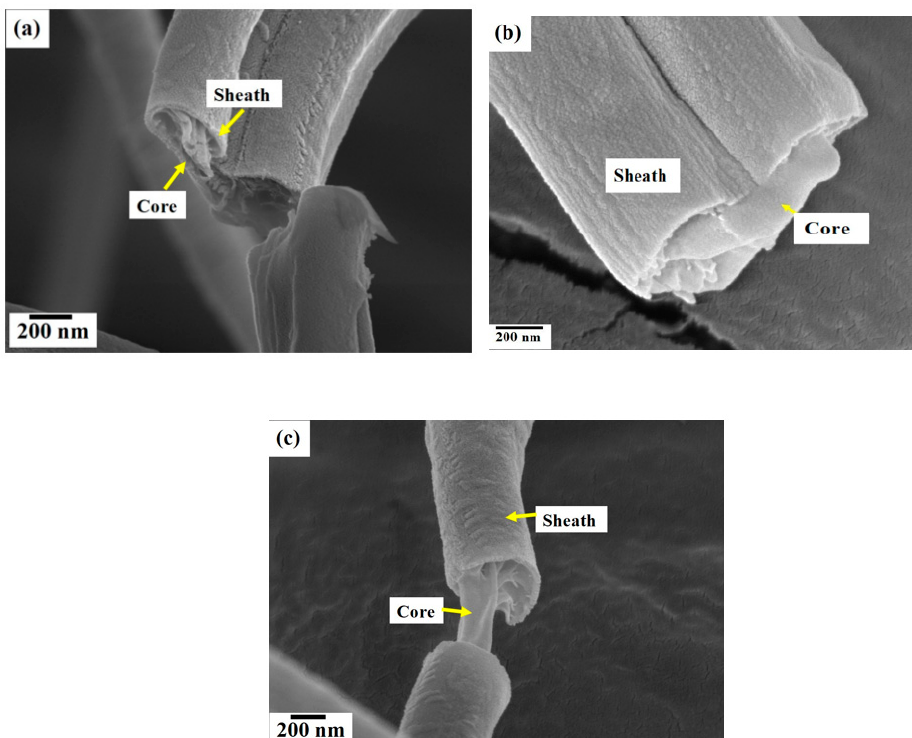
Figure 5. Core–sheath nanofiber cross-sections uncovered using focused ion beam milling. Rotating speed of 6000 RPM and different working pressures (MPa) ( a ) 0.1 ( b ) 0.2 ( c ) 0.3.